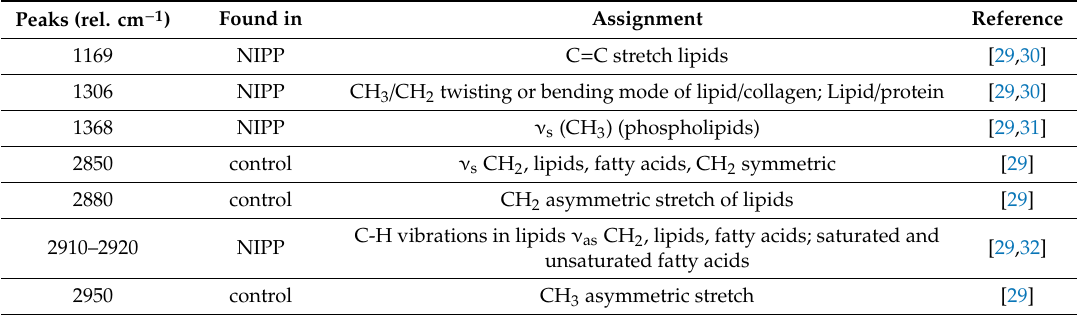
Table 1. Identified characteristic Raman peaks [rel. cm − 1 ] linked to lipid components and their molecular assignments according to literature. Peaks (rel. cm − 1